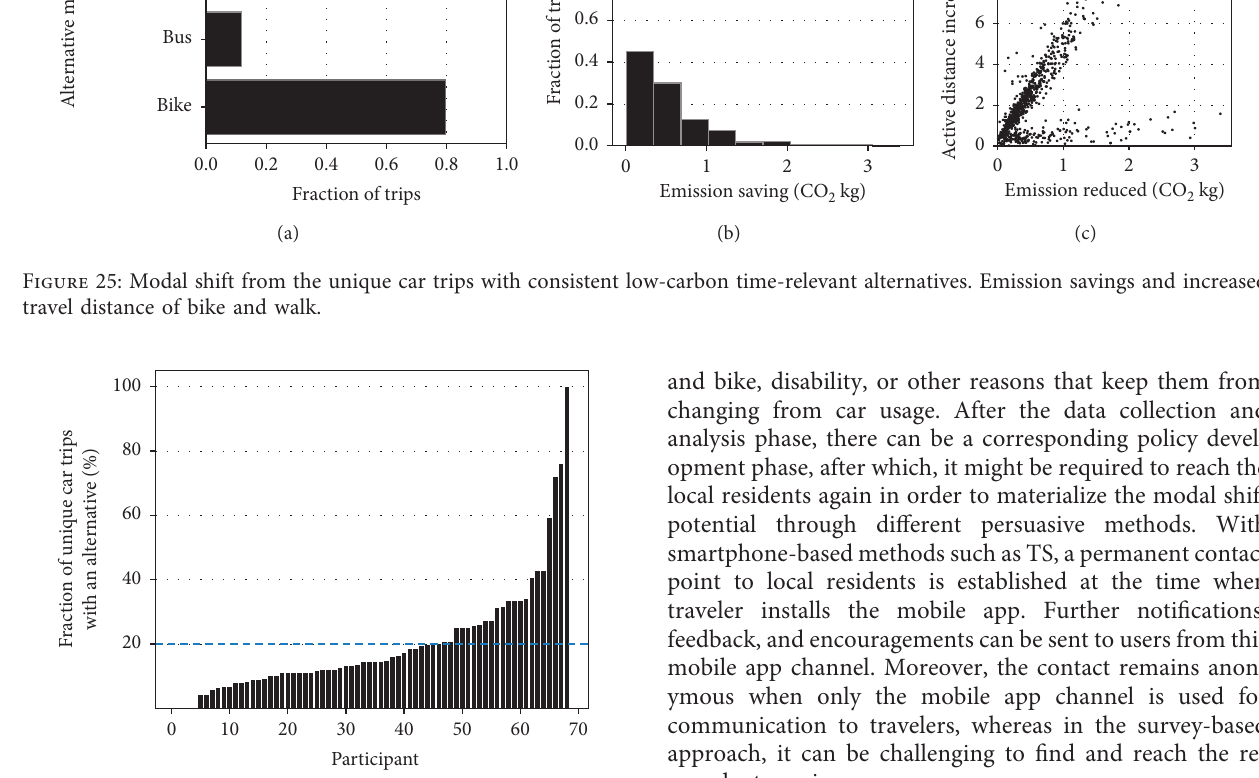
Mean = Figure 26: Potential of time-relevant modal shift from unique car trips among active